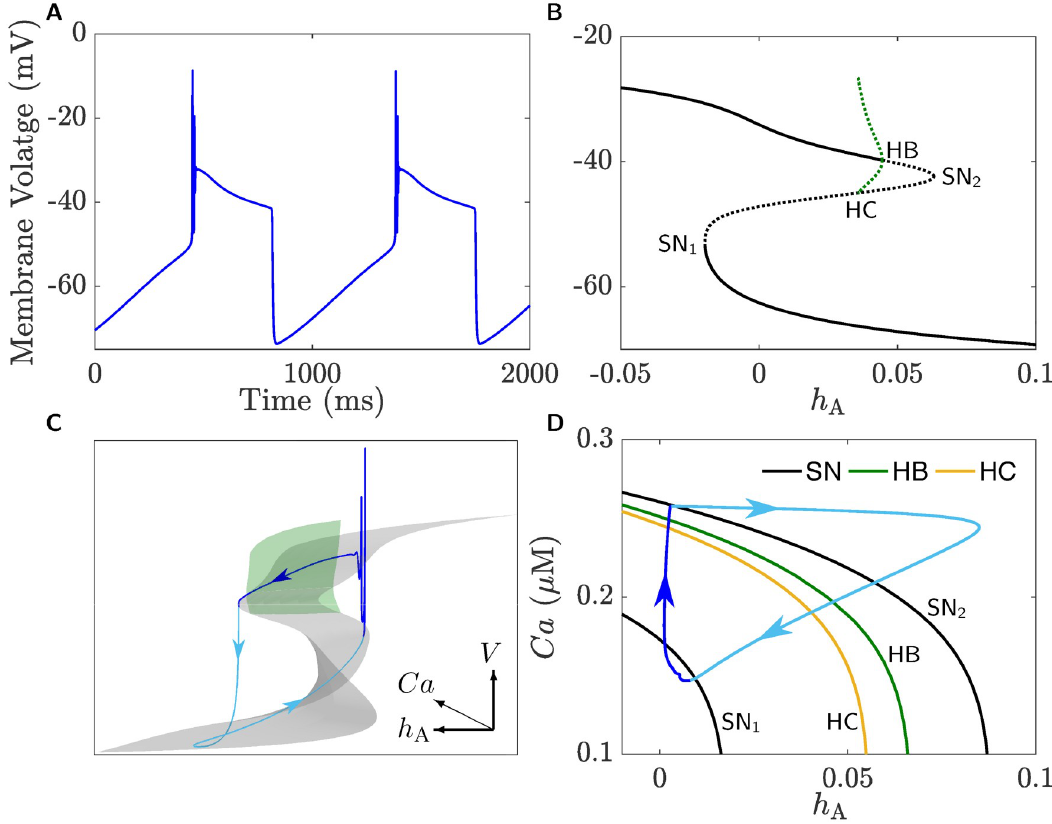
Fig 13. Pseudo-plateau bursting in the CSC model defined by the full system (1). A ) Time course of the membrane voltage V when g V , with respect to h A using the same values of maximum conductances listed in A . As in Fig 10, the stable (unstable) branches of equilibria are plotted as solid (dotted) lines, while envelopes of unstable periodic orbits are plotted as green dotted lines. Notice the absence of the isola near SN 1 seen in Fig 10. C ) The BPO shown in panel A superimposed on the critical manifold of system (1) shown as a gray surface in the ( h A , Ca , V )-space. The family of envelopes of unstable periodic orbits emanating from the curve of Hopf bifurcations lying on the upper sheet of the critical manifold is shown as a green surface. D ) Two-parameter continuation of the bifurcation points SN 1 , SN 2 , HB and HC detected in panel B plotted in the ( h A , Ca )-space along with one pseudo- plateau bursting cycle (blue); the flow direction is indicated with the arrows and active and silent phases are shaded dark and light blue, respectively. The bifurcation curves are color-coded according to the